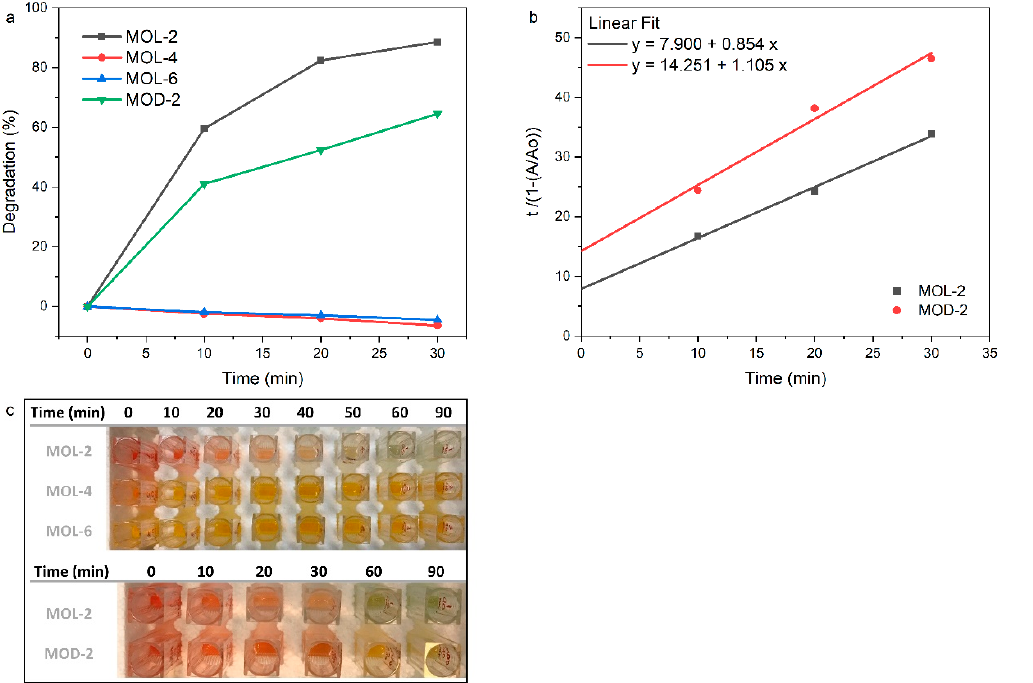
Figure 5. ( a ) The percentage of the MO dye degradation, ( b ) the linear fitting of the MO experimental data with the BMG kinetic model and ( c ) photographs of the degraded MO dye during 90 min by the same catalyst in different pH values under the sunlight and the darkness.